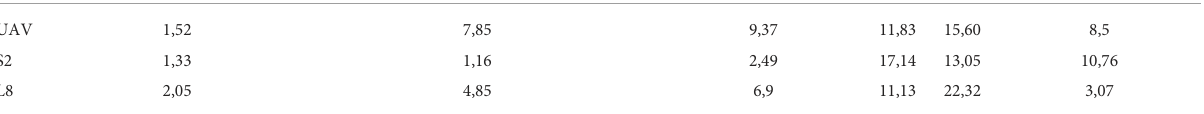
TABLE 3 Areas (in ha) of SVM classi fi cation for each sensor (UAV, S2 and L8). Sensor Beached R. okamurae In-water and underwater R. okamurae Total R. okamurae Water Soil Terrestrial